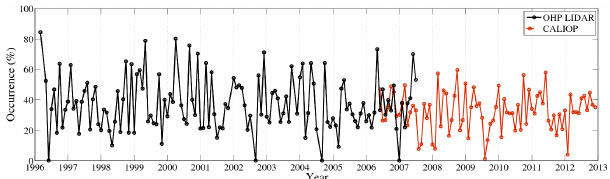
Figure 15. Evolution of cirrus clouds occurrence from the OHP lidar (black) and CALIOP 2 Fig. 15. Evolution of cirrus clouds occurrence from the OHP lidar (red), considering all cirrus clouds. 3 (black) and CALIOP (red), considering all cirrus